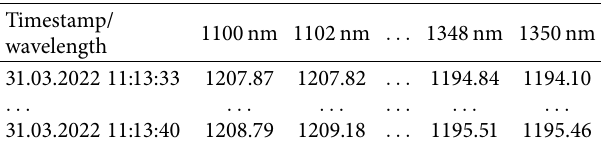
Table 3: A visual representation of raw measurement data (sample 1, sensor S1.4).